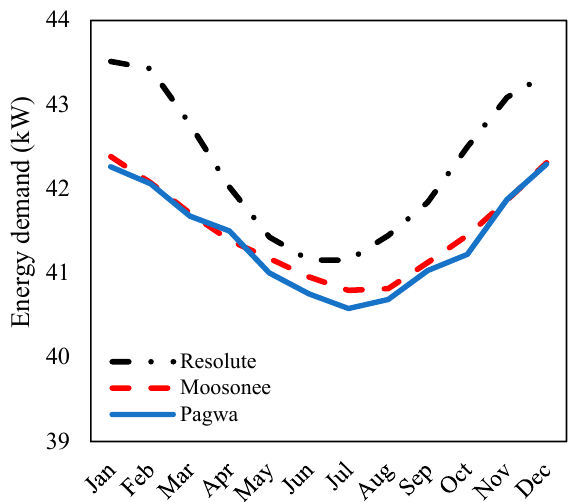
(cid:48) × 30 (cid:48) greenhouse.